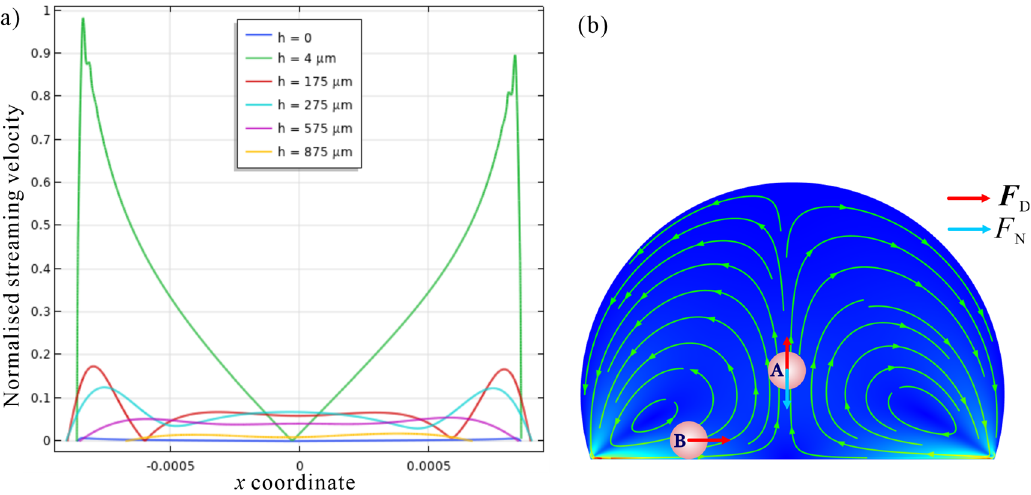
Figure 4. ( a ) The intensity of acoustic streaming in the droplet of different cross-sections. The height of the droplet is 1.14 mm. ( b ) The force conditions for particles to gather in two positions.